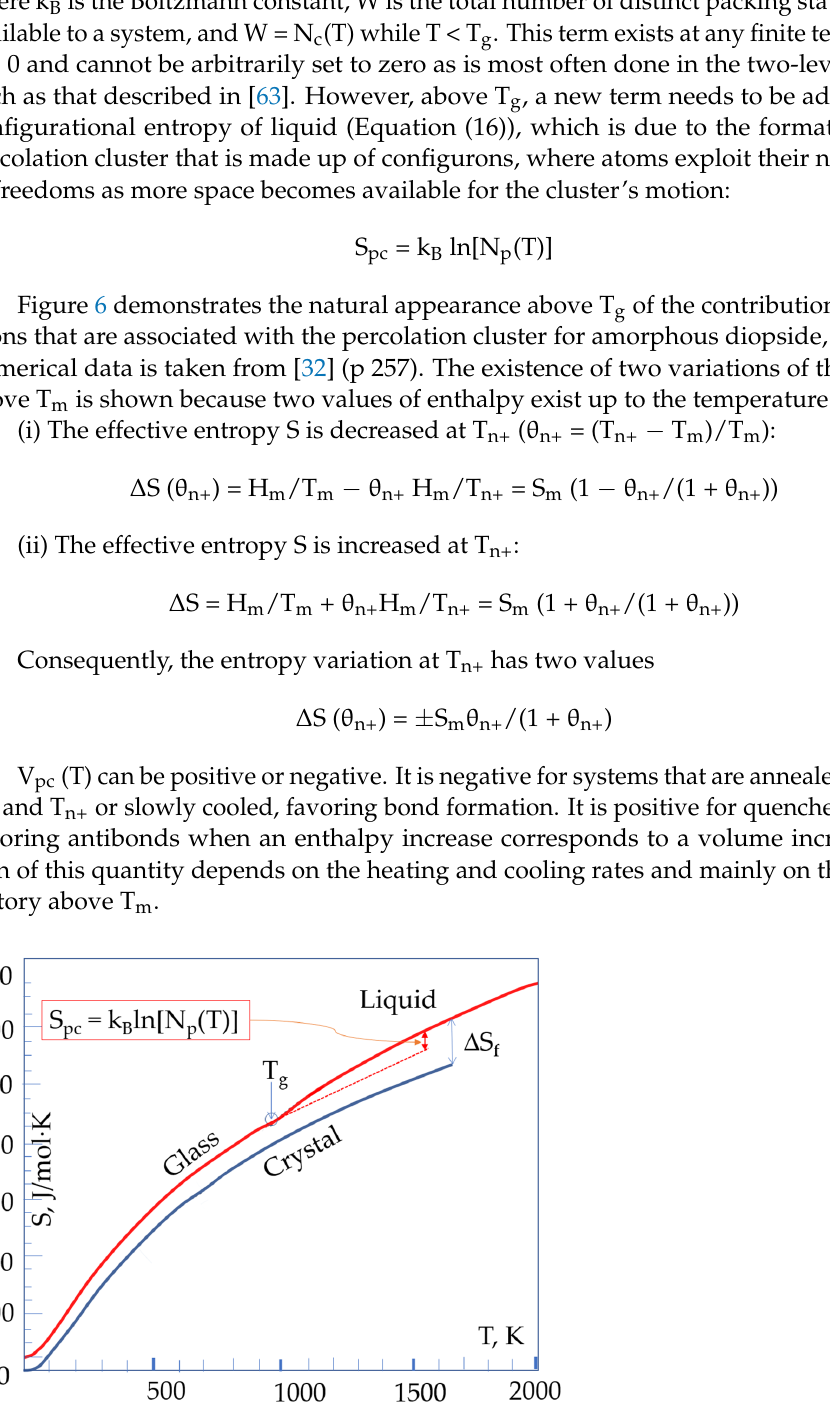
Figure 6. The temperature dependence of the entropy of amorphous and crystalline phases of diopside with the explicit contribution of a configuron percolation cluster above the T g . Δ S f shows the entropy difference between the liquid and the crystalline phases at the melting temperature.